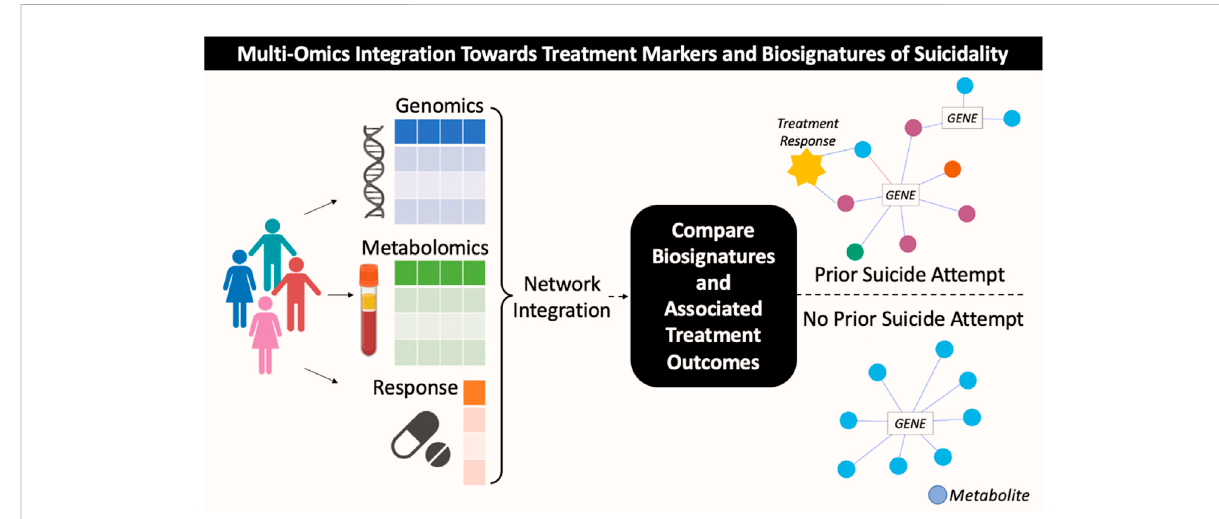
FIGURE 1 Conceptual overview of multi-omics integration analysis towards identi fi cation of candidate treatment markers for subgroups of patients with MDD based on history of suicide